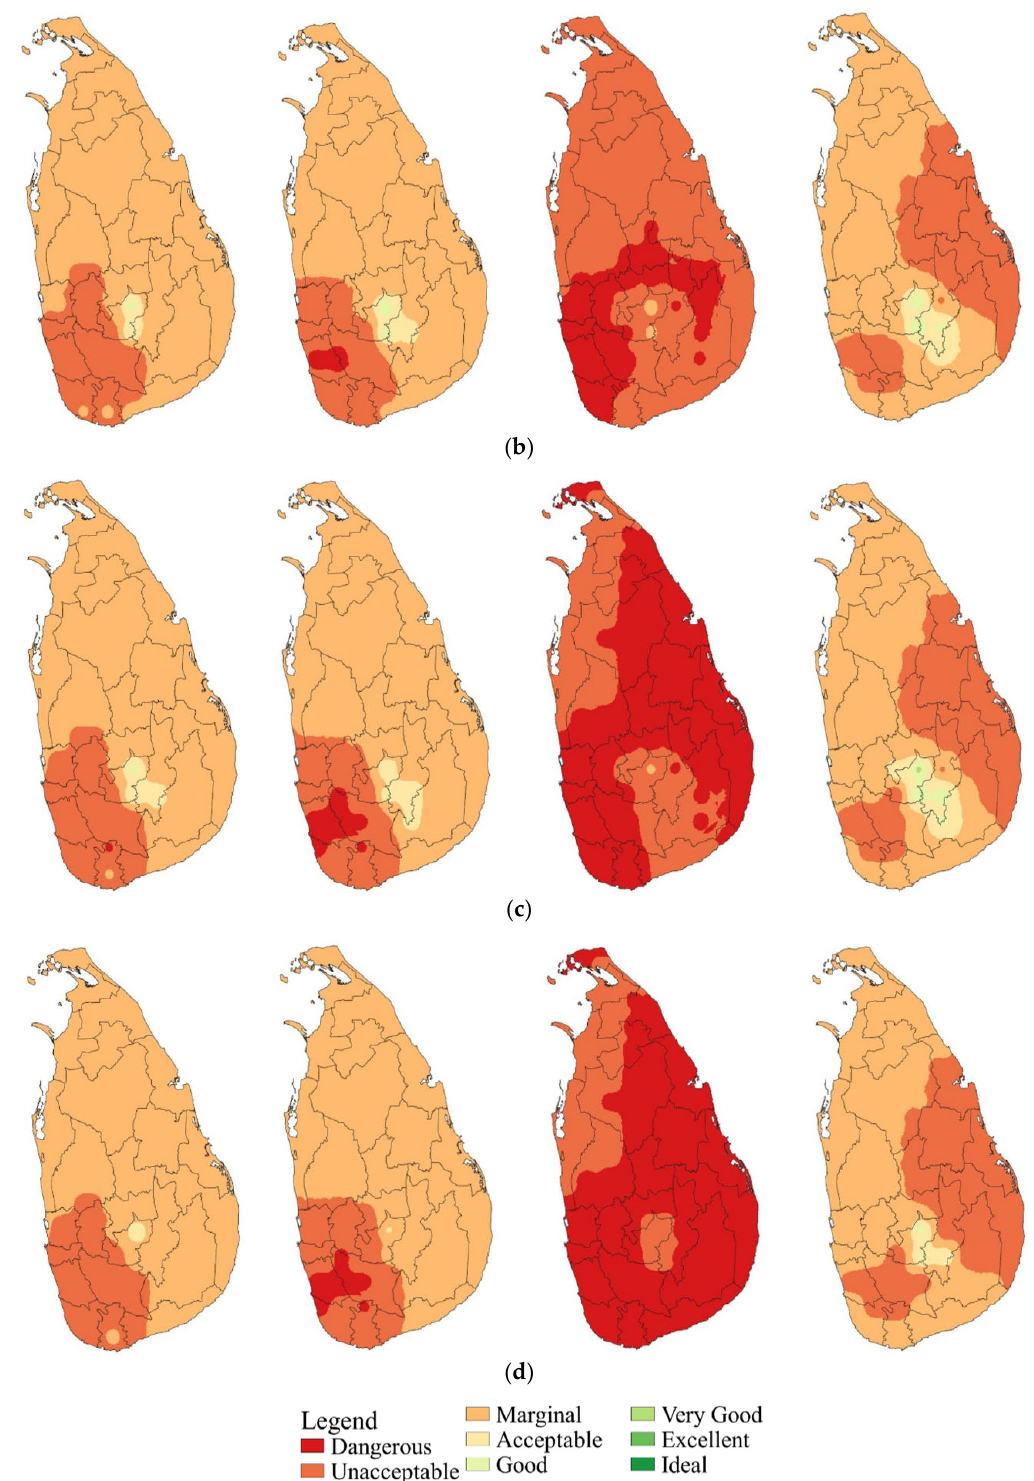
Figure 7. Spatial distribution of HCI Urban score under RCPs: ( a ) For RCP4.5 2021–2050; ( b ) For RCP4.5 2071–2100; ( c ) For RCP8.5 2021–2050; ( d ) For RCP8.5 2071–2100.